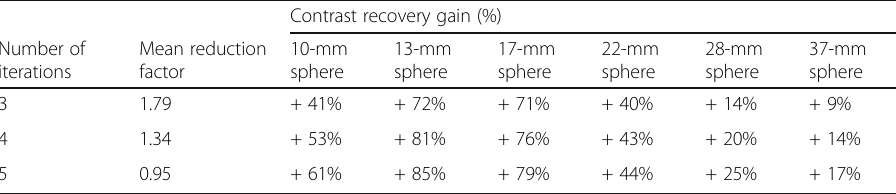
Table 4 Scan time reduction factor and CR gain for different numbers of iterations (Vision with 440 × 440 matrix size) when compared to the reference values of mCT Contrast recovery gain (%)